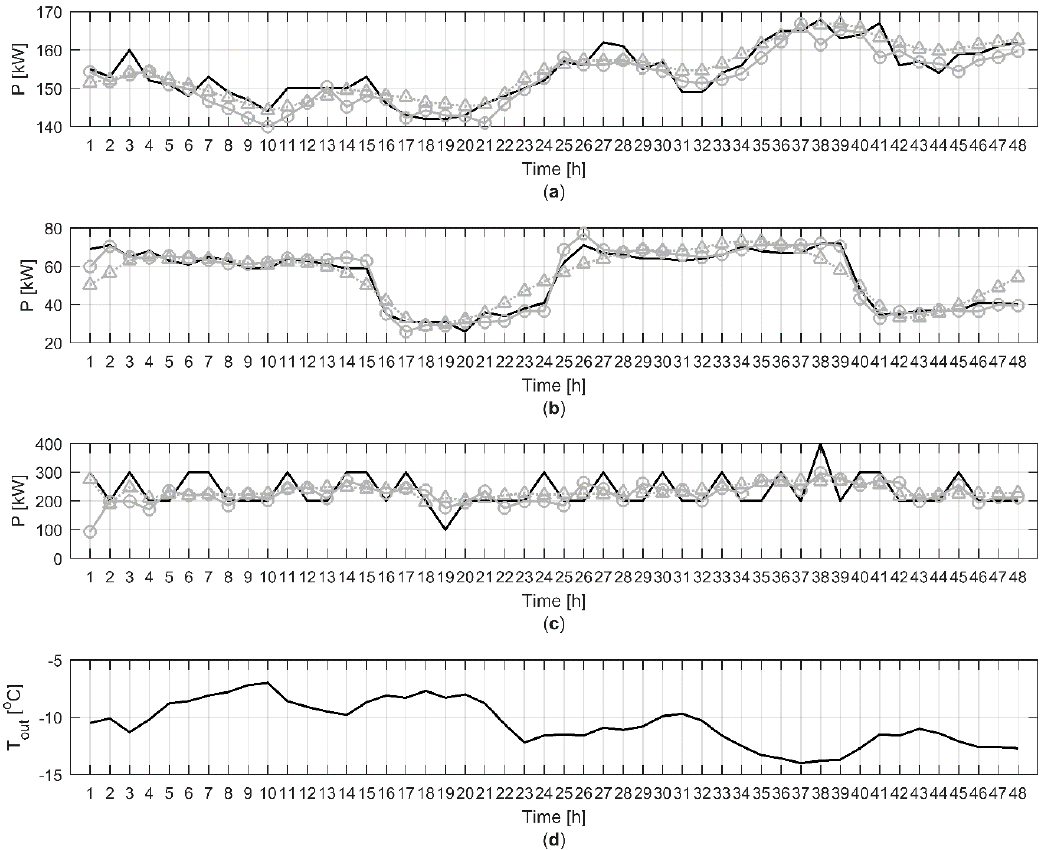
Figure 6. Predicted and measured heat demand in three different buildings for 48 h with validation data